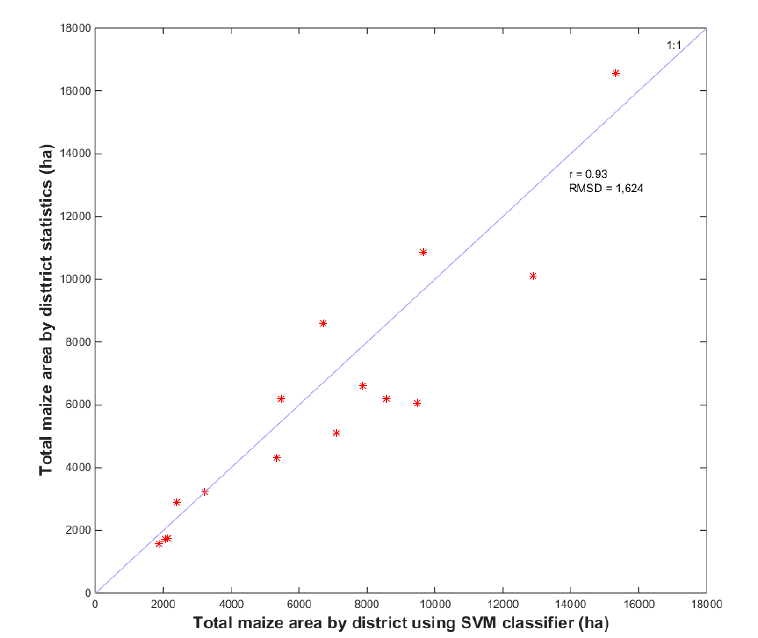
Figure 9. Comparison of the summarized maize areas estimated by the Support Vector Machine (SVM) classification and the 2018 official statistical data for 15 districts of Dak Lak.